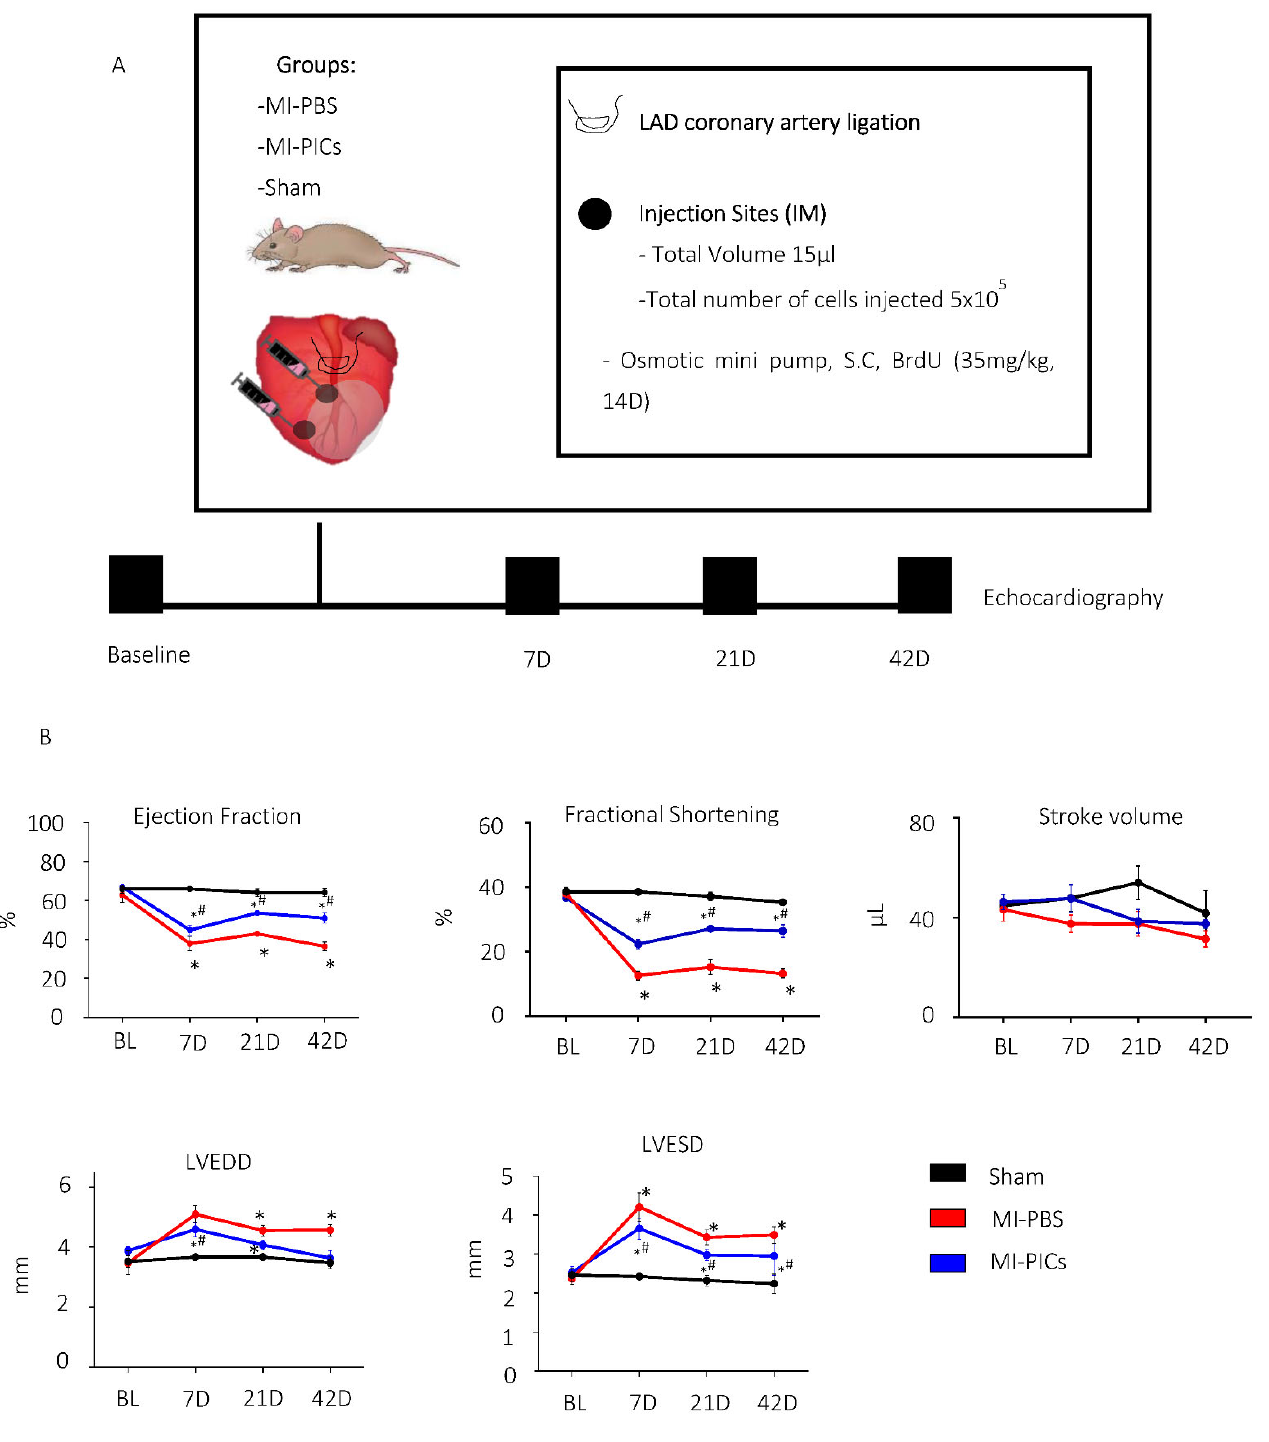
Figure 1. PIC transplantation improves cardiac function after MI. ( A ) Schematic diagram of experimental design and echocardiography measurements were taken, before myocardial infarction (MI) (baseline); 7 days, 21 days and 42 days after MI. Post BL echocardiography, animals underwent MI surgery with PBS, MI with PICs or Sham surgery. ( B ) Changes in cardiac function post ‐ MI. EF = ejection fraction, FS = fractional shortening, SV = stroke volume, LVEED = left ventricular end diastolic dimension, LVESD = left ventricular end systolic dimension. Sham = 8, MI ‐ PICS = 7 and MI ‐ PBS = 7. Data expressed as Mean ± SEM, * p < 0.05 vs. Sham, # p < 0.05 vs. MI ‐ PBS.